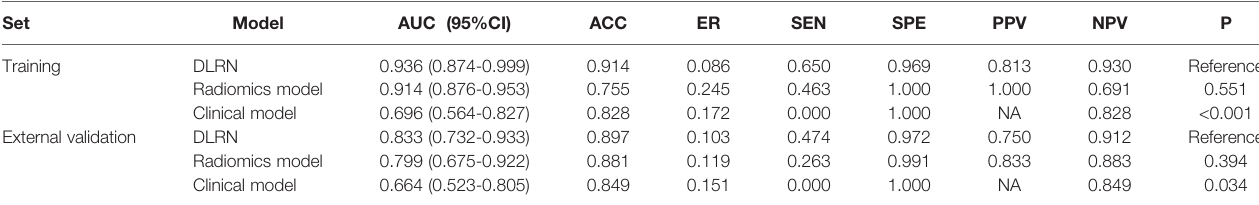
TABLE 3 | Results of clinical model, radiomics model and DLRN predictive performance.